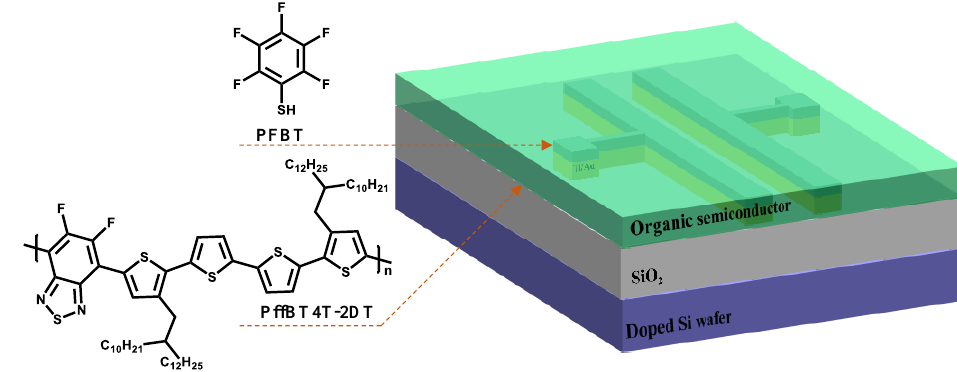
Figure 1. Chemical structures of PFBT (top) and PffBT4T-2DT (bottom) and schematic structure of the fabricated OFET.